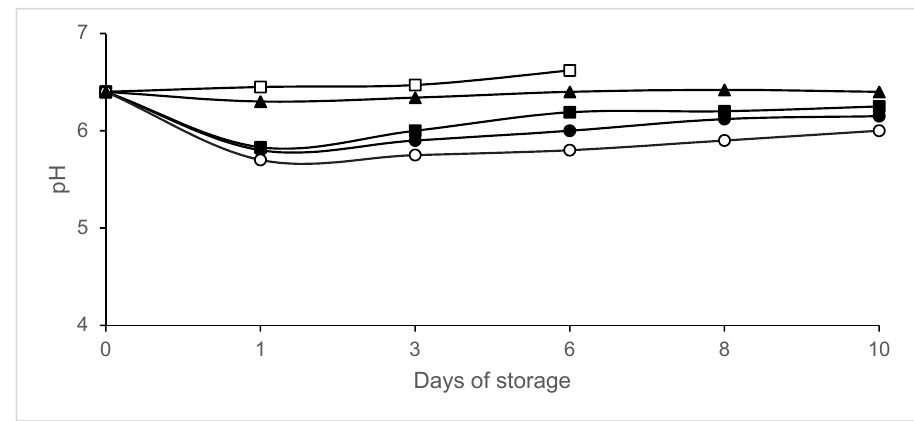
Figure 2. Effect of packaging conditions on the growth of L. monocytogenes on chicken legs packaged in modified atmospheres. Packaging conditions: Batch A0, air ( □ ); Batch A20, 80% N 2 /20% CO 2 ( ▪ ); Batch A40, 60% N 2 /40% CO 2 ( • ); Batch A60, 40% N 2 /60% CO 2 ( ◦ ); Batch AV, vacuum ( ▲ ). Data shown are each the mean value of six determinations.